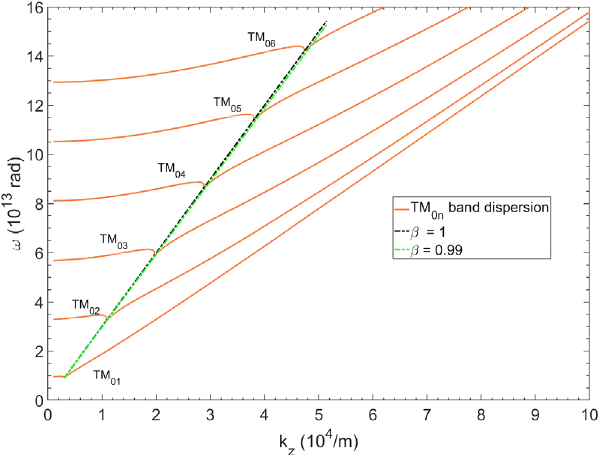
FIG. 2. Dispersion for the first six TM bands with a ¼ 100 μ m, b ¼ 120 μ m. Two light lines with β ¼ 1 and β ¼ 0 . 99 are shown and the intersection points determine the corresponding modes.